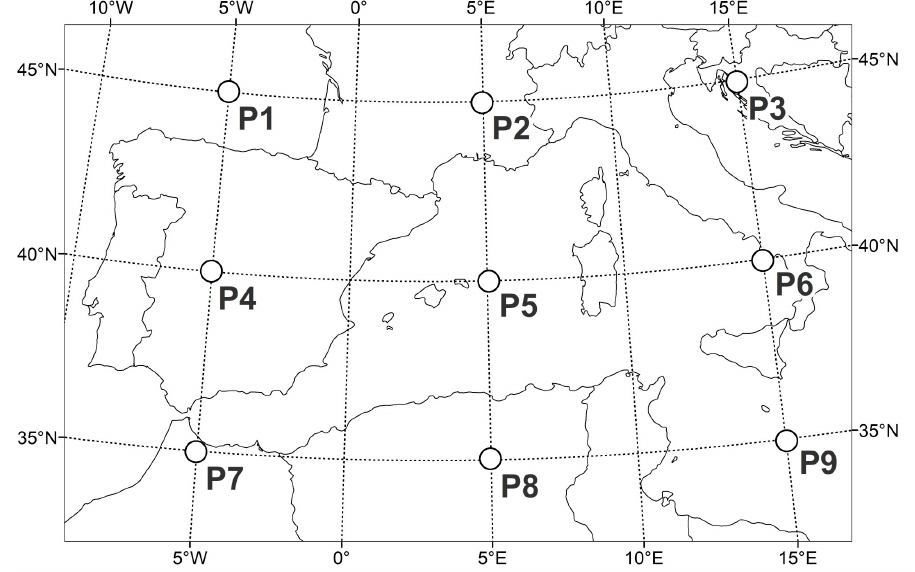
Figure 2. Grid for using the Jenkinson and Collison method .